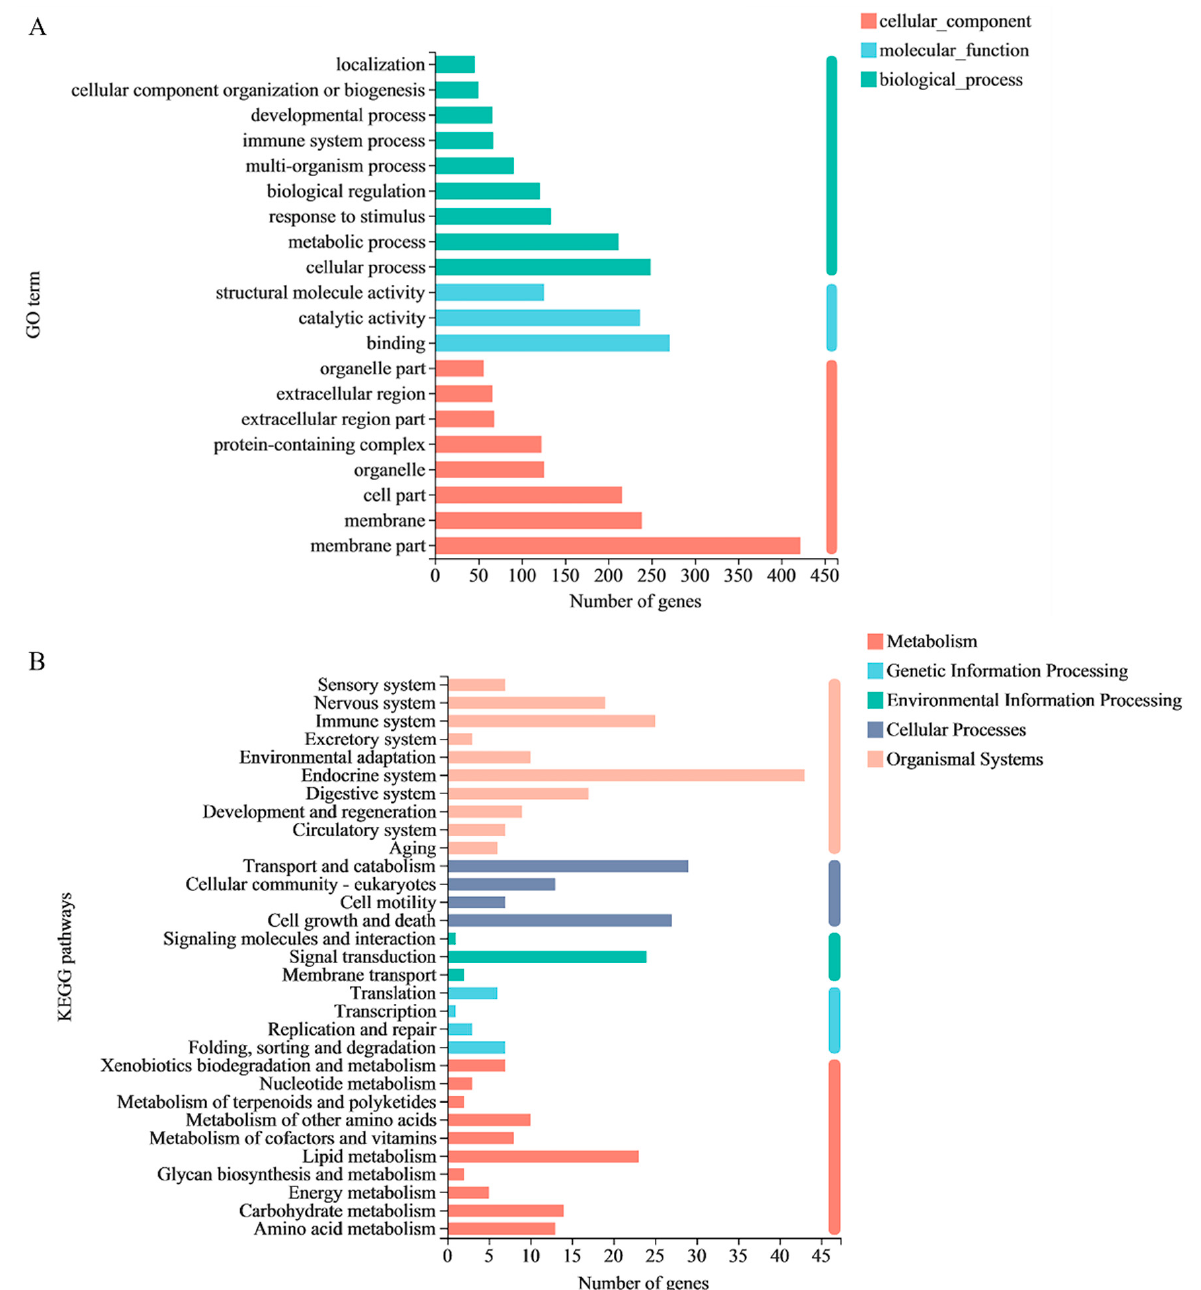
Figure 3. ( A ) Top 20 GO terms based on the transcriptome of QBLP-treated C. elegans relative to that of control worms. ( B ) Top pathways that were altered after QBLP treatment in C. elegans .